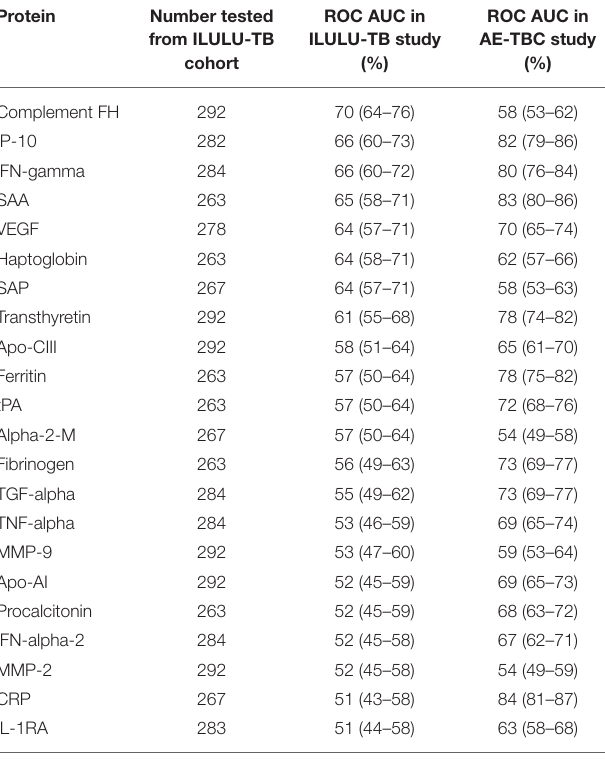
TABLE 3 | Diagnostic accuracy of protein biomarkers individually. Protein Number tested ROC AUC in from ILULU-TB ILULU-TB cohort